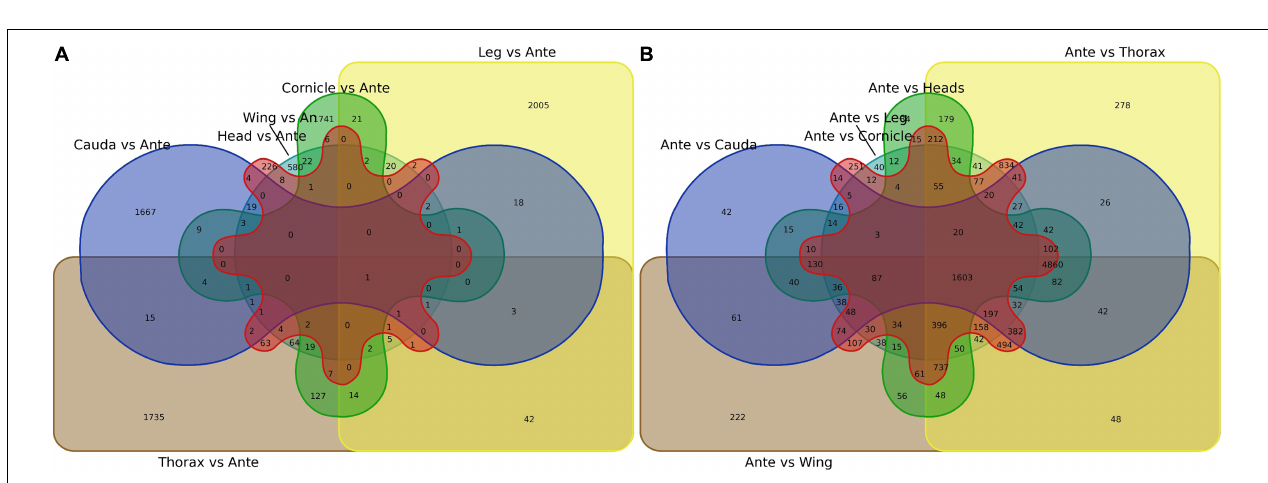
FIGURE 1 | Volcano plots for differentially expressed genes between antennae and each of the other six tissues (heads, legs, caudae, cornicles, thoraxes, and wings).